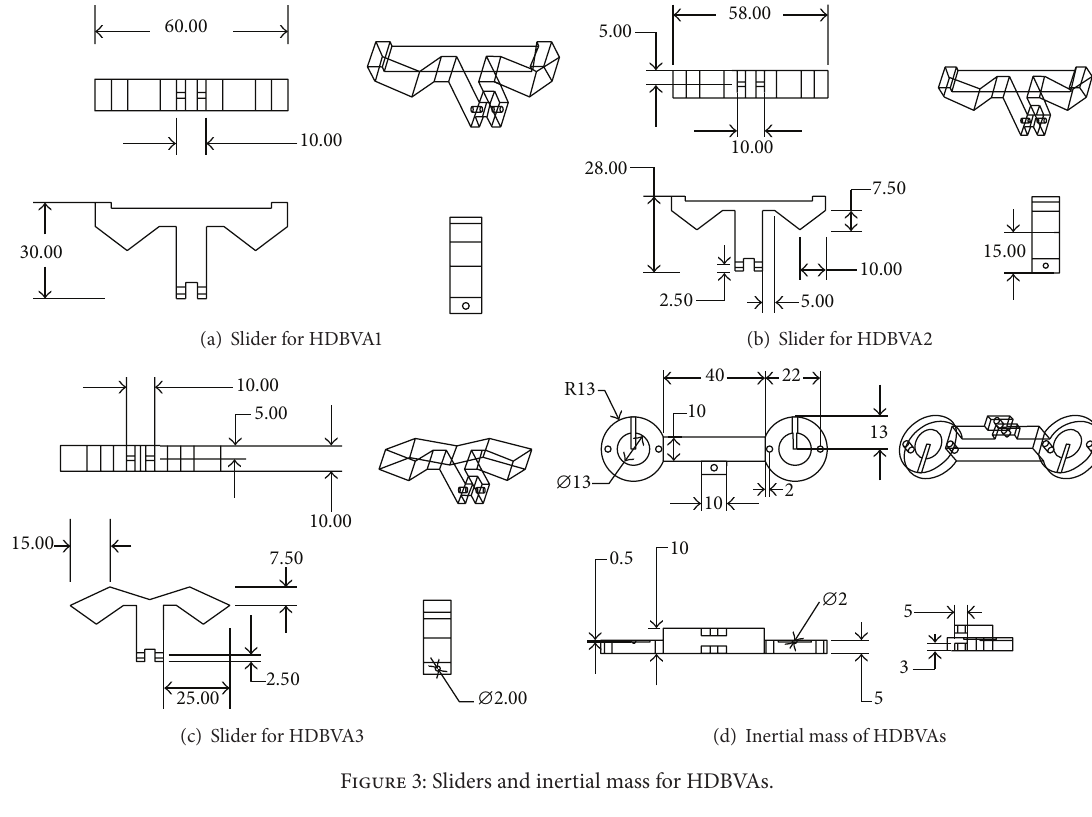
Figure 3: Sliders and inertial mass for HDBVAs.